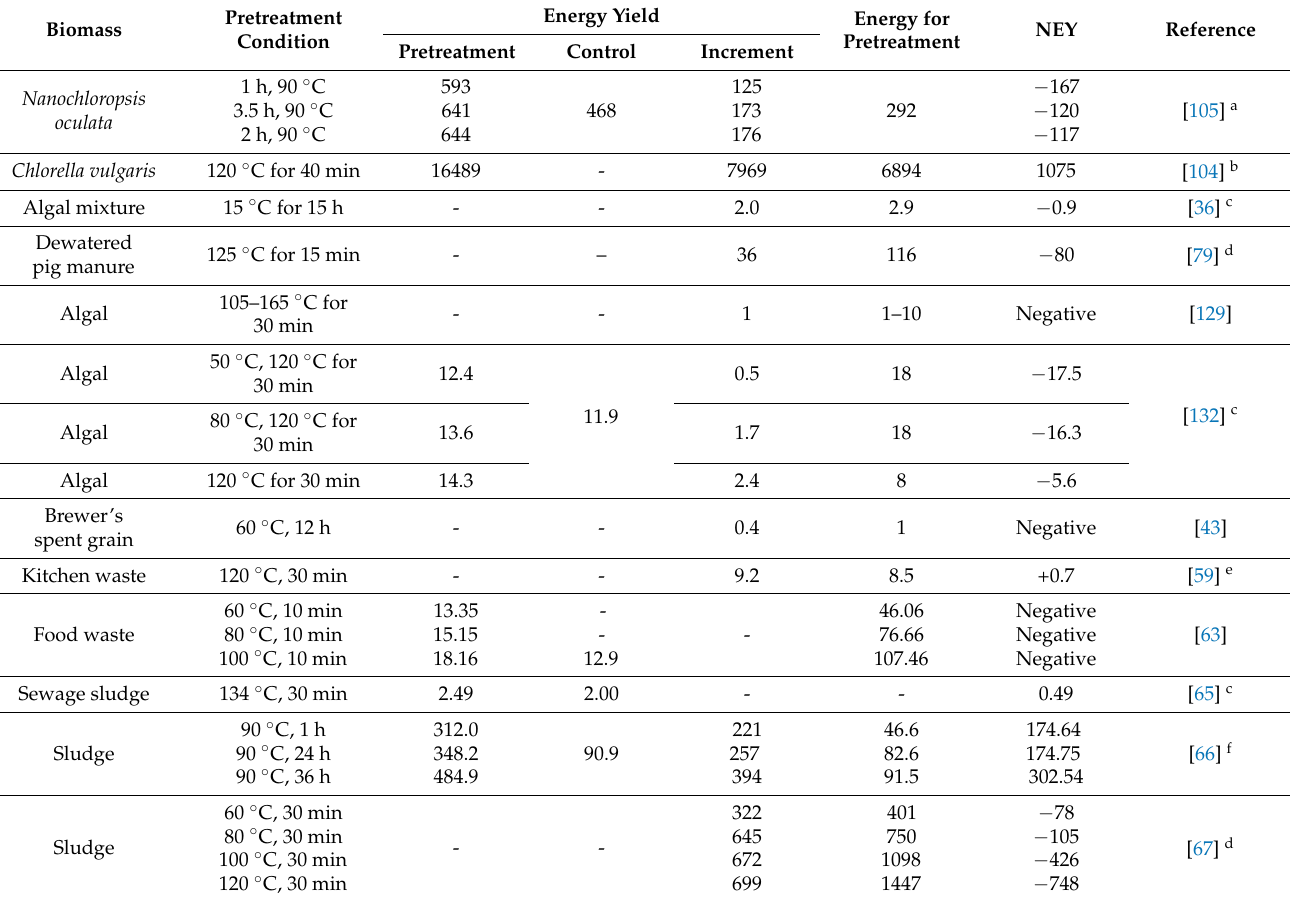
Table 7. Energy balance between thermal pretreatment and biogas